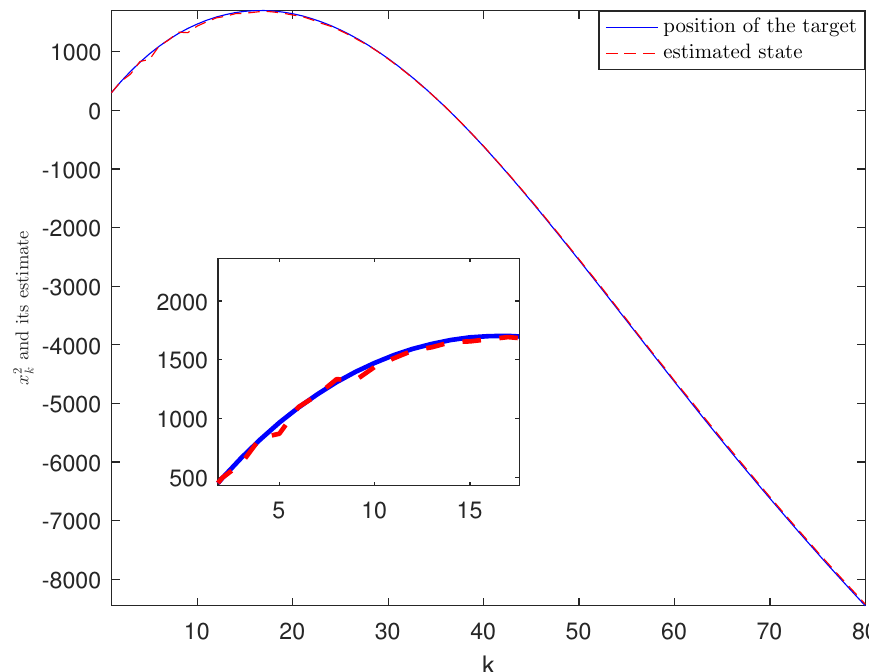
Figure 8. The position of the target x 2, k and its estimate.